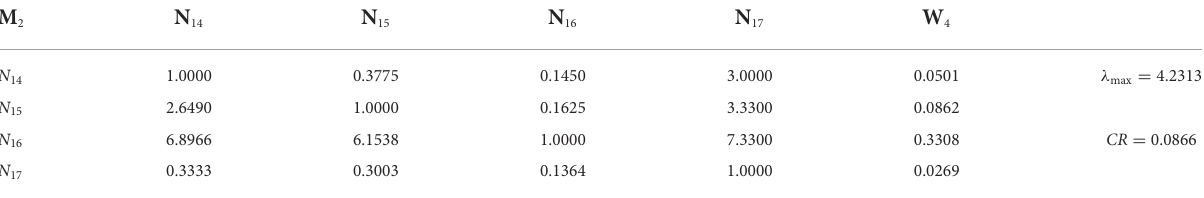
TABLE 8 Consistency ratio of user experience criteria judgment matrix and its